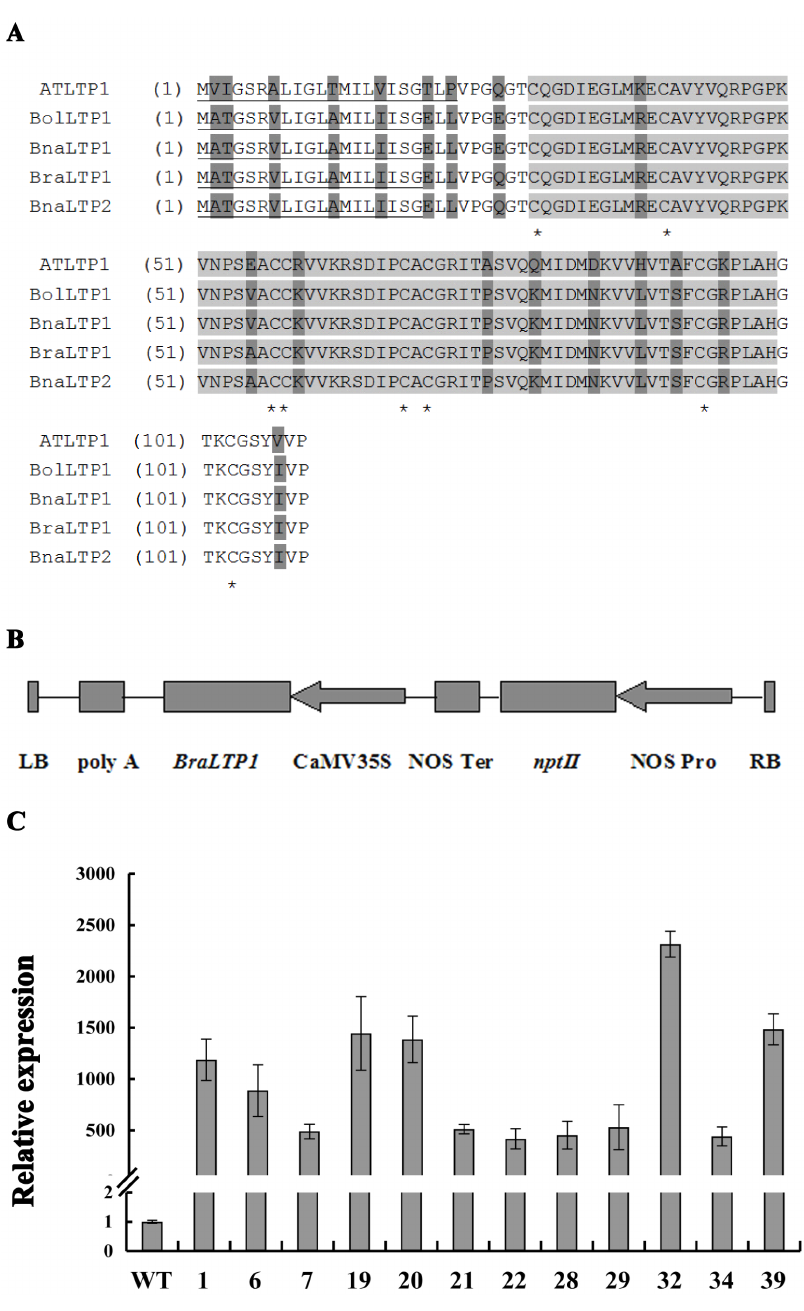
Figure 1. Basic protein characteristics of BraLTP1 and vector construction. (A) Analysis of the deduced amino acid sequences of BraLTP1 with its homologous sequences in other cruciferae; variable sites (dark grey)the nsLTP-like conserved 8 CM domain (light gray) with conserved cysteine residues (asterisks) and putative extracellular secretory signals (underlined). Sequences are from Arabidopsis thaliana AtLTP1 (AT4g30880), B. rapa BraLTP1 (Bra011229) [32], B. oleracea BolLTP1 (Bol018048) [60], B. napus BnaLTP1 (AY208878), and B. napus BnaLTP2 (KM062522). (B) T-DNA region of the BnaLTP1 overexpression construct containing BnaLTP1 driven by the CaMV 35S promoter. LB=Left border, RB=Right border, poly A=poly A terminator, nptII =kanamycin resistance, NOS Ter=nopaline synthase terminator, NOS Pro=nopaline synthase promoter. (C) Analysis of BraLTP1 mRNA levels in 10-week-old wild type (WT) and T0 35S::BraLTP1 transgenic plants by qRTPCR. Transgenic plants include BraLTP1-1, -6, -7, -19, - 20, -21, -22, -28, -29, -32, -34 and -39 . Standard errors were derived from three repeated experiment for the expression levels of each plants.